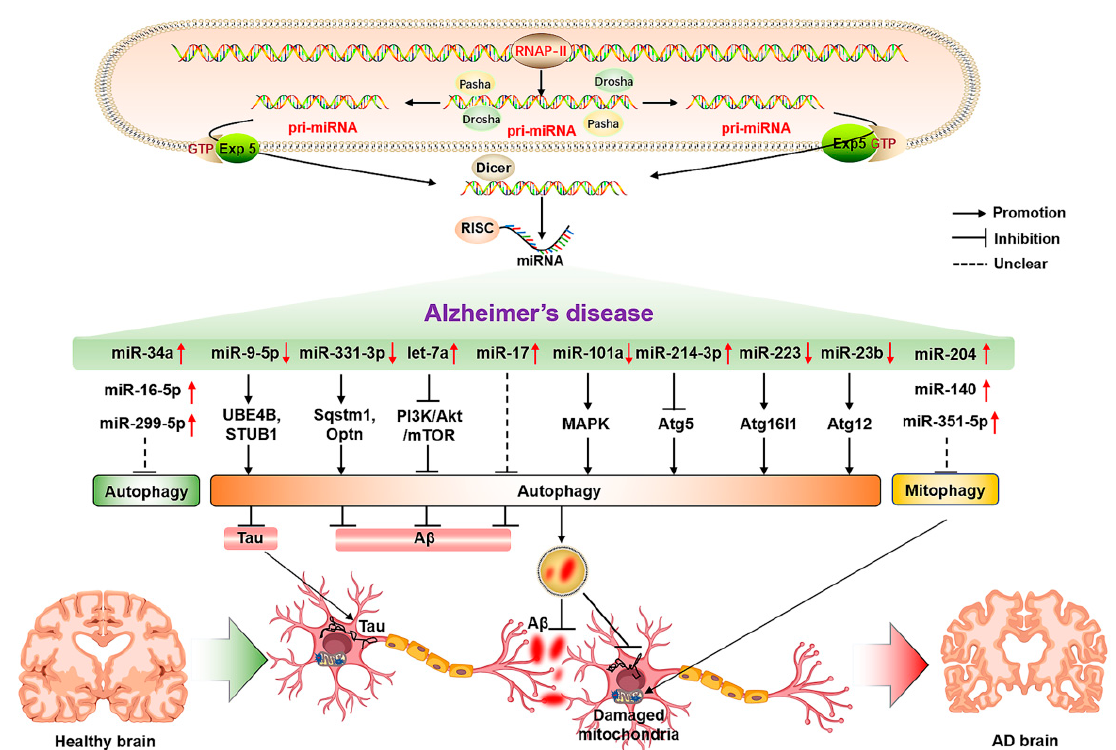
nucleus translocation of TFEB after dephosphorylation, thereby binding autophagy ‐ and lyso ‐ Figure 2. The molecular mechanisms of miRNA ‐ mediated autophagy in AD. The ↑ and ↓ in some ‐ related genes, and enhancing autophagic flux. The ↑ in red color represents the increased Figure 2. The molecular mechanisms of miRNA-mediated autophagy in AD. The ↑ and ↓ in red color